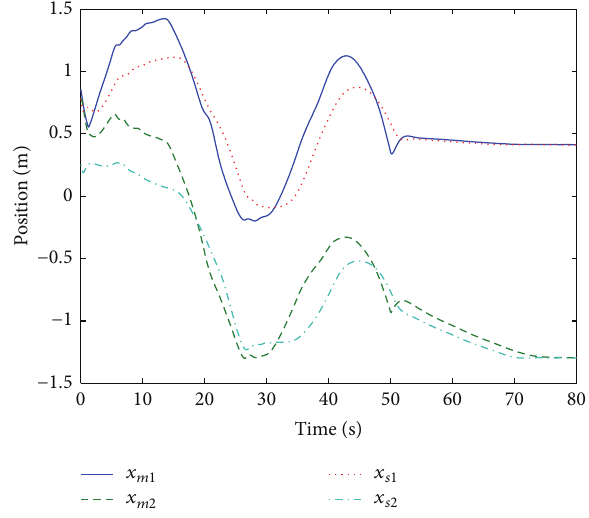
Figure8:Thepositionsofthemasterandtheslaveintaskspacewith adaptive